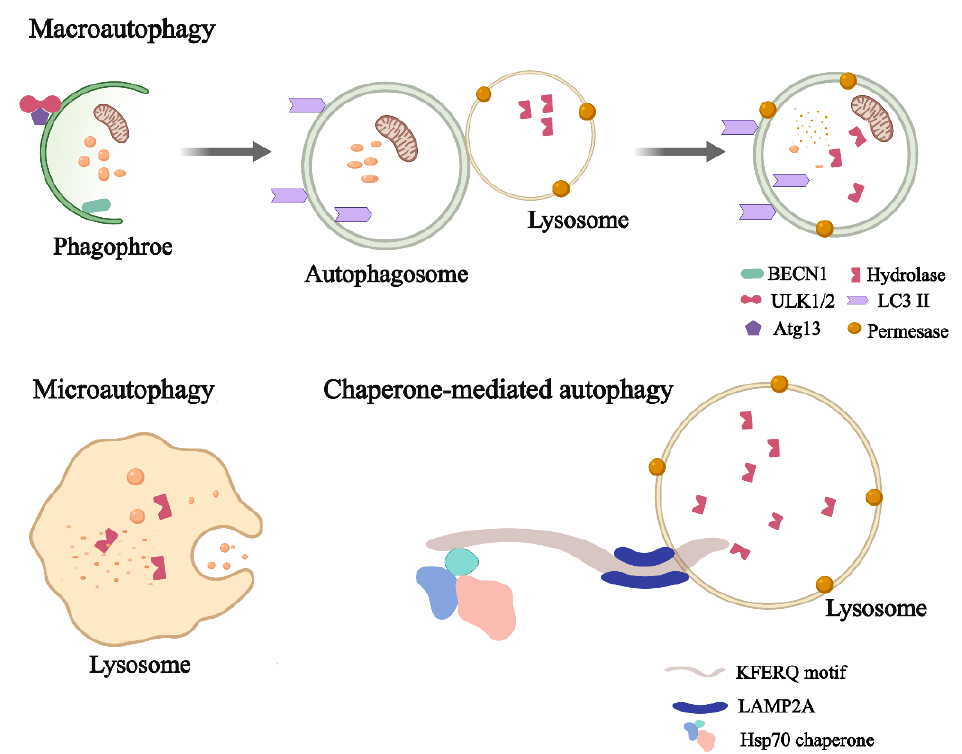
Figure 1. Classification of autophagy. Autophagy can be divided into macroautophagy, microautophagy, and chaperone-mediated autophagy. BECN1, beclin 1; ULK1/2, UNC-51-like kinase 1, UNC-51-like kinase 2; LC3 II, microtubule-associated protein light chain 3 II; Atg 13, autophagy-related gene 13; LAMP2A, lysosomal-associated membrane protein 2; Hsp70, heat shock protein